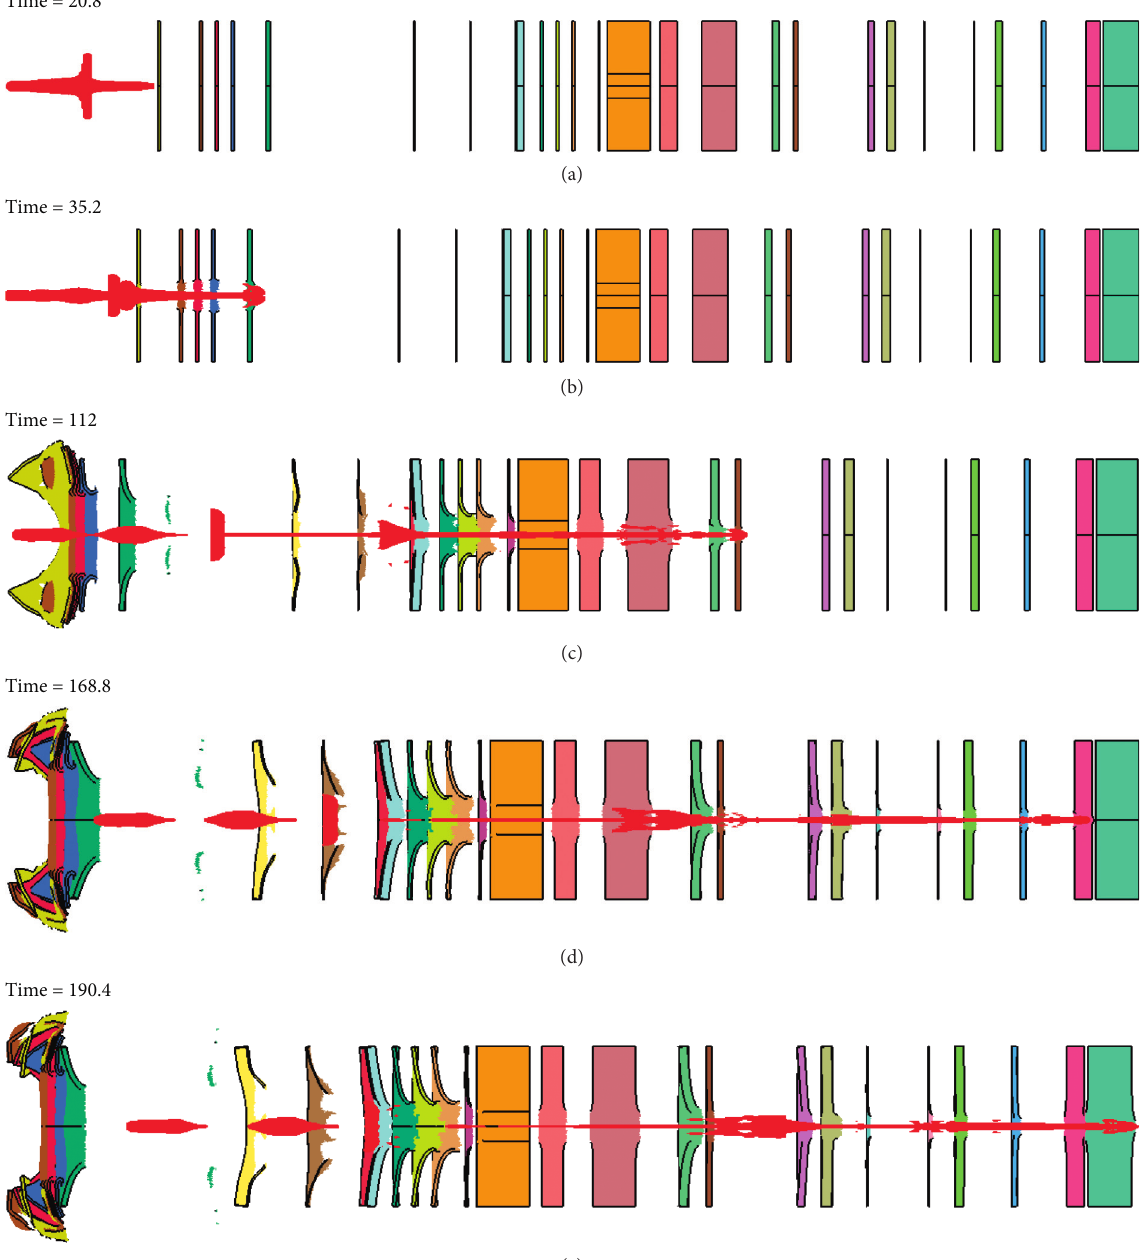
Figure 9: Penetration results of jet formed when liner material is aluminum: (a) the SCJ at observation point 1; (b) the SCJ at observation point 2; (c) the SCJ at observation point 3; (d) the SCJ at observation point 4; (e) the SCJ at observation point